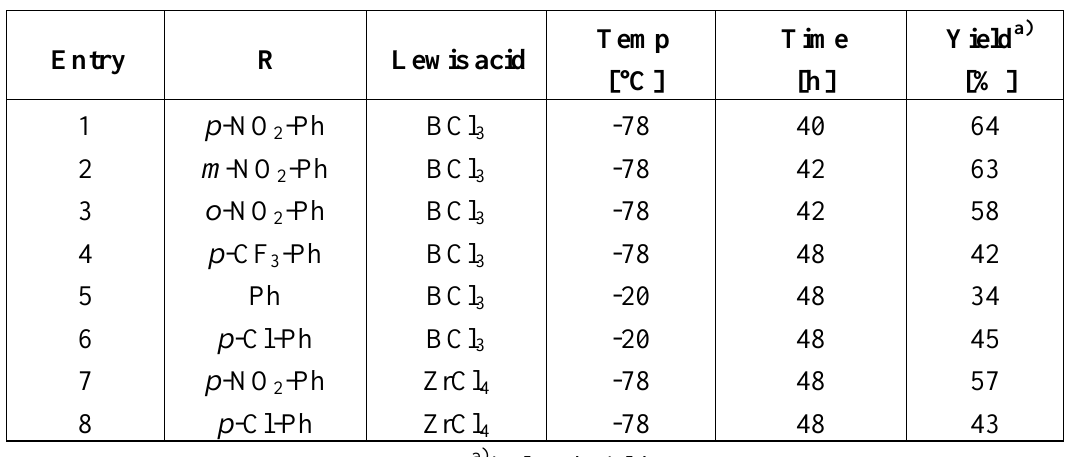
Table 4. Baylis-Hillman Reaction of Aldehydes with Methyl Vinyl Ketone in